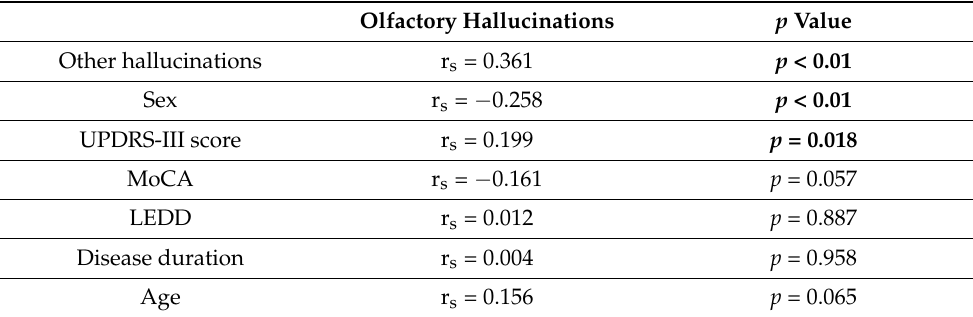
Table 4. Binary logistic regression models for clinical variables predicting presence of olfactory hallucinations in PD patients. B S.E. Wald p Exp(B) Presence of visual/auditory 1.543 0.649 5.658 0.017 4.680 hallucinations Sex − 1.365 0.644 4.500 0.034 0.255 UPDRS-III score 0.030 0.022 1.822 0.177 1.030 − 0.037 0.055 0.449 0.503